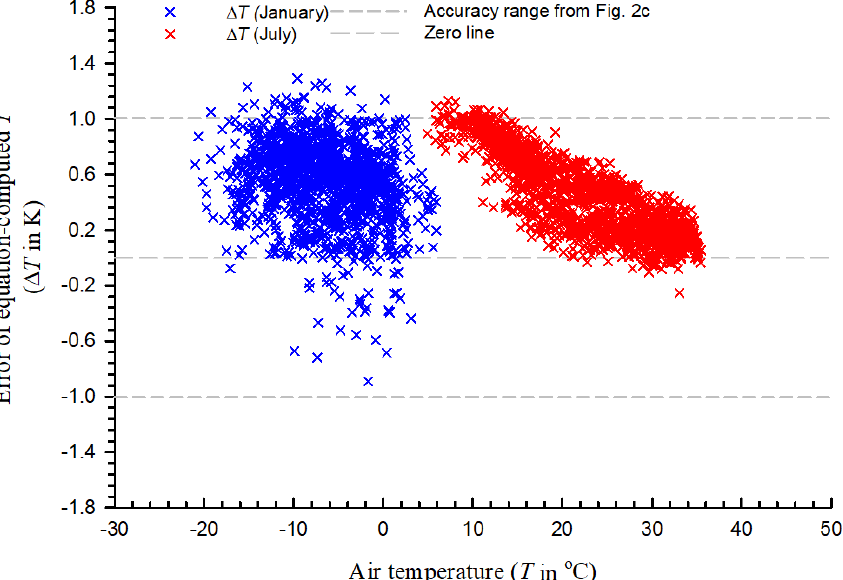
Figure 4. The error in equation-computed T in the coldest (January) and hottest (July) months of 2019 in Logan, UT, USA. (cid:49)T is equation- computed T minus RTD-measured T , where RTD denotes a precision platinum resistance temperature detector inside a fan-aspirated radia- tion shield. (cid:49)T is 0.549 ± 0.281K in January and 0.436 ± 0.290K in July. See Fig. 2c for the accuracy